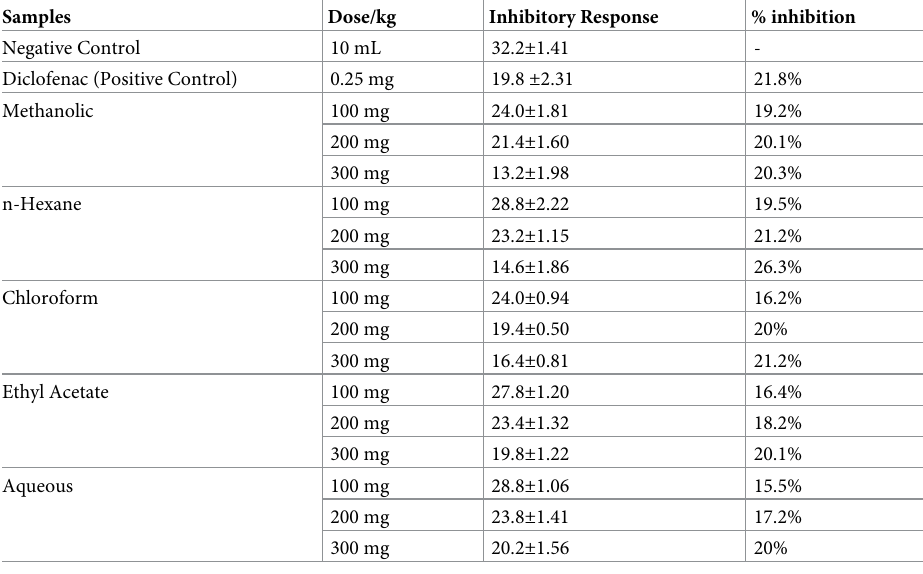
Table 4. Effect of IACCF on acetic acid-induced abdominal constriction in mice.